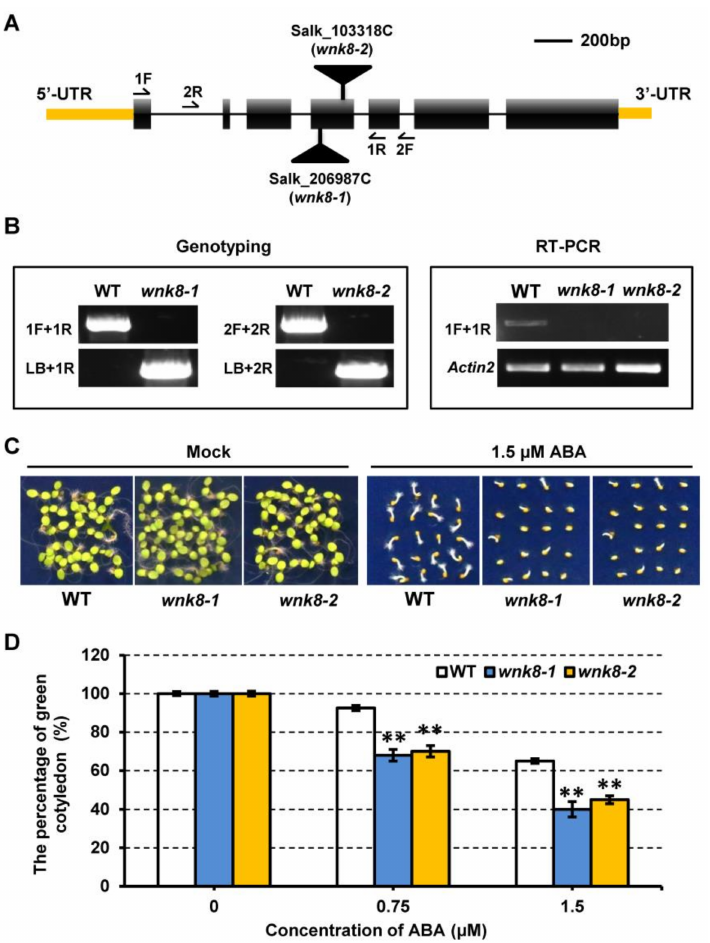
Figure 1. WNK8 negatively regulates ABA response during seed germination and post-germination development. ( A ) Schematic presentation of the WNK8 gene. 5 (cid:48) and 3 (cid:48) -UTR are highlighted with yellow boxes. Introns are depicted by solid lines and exons are indicated by black boxes. Two black triangles represented the T-DNA insertion sites of respective wnk8 alleles. Positions of oligonu- cleotides used for genotyping and RT-PCRs in ( B ) are indicated by arrows. ( B ) Genotyping and RT-PCRs analysis in Col-0 wild-type (WT) and wnk8 alleles. Actin2 was used as the internal control. ( C ) Representative images for seed germination of Col-0 and wnk8 alleles in the absence or presence of ABA. ( D ) Cotyledon greening rates of indicated genotypes when grown on media supplemented with different concentration of ABA. Data indicate repeat experiments ( n = 4). Asterisks indicate significant differences to